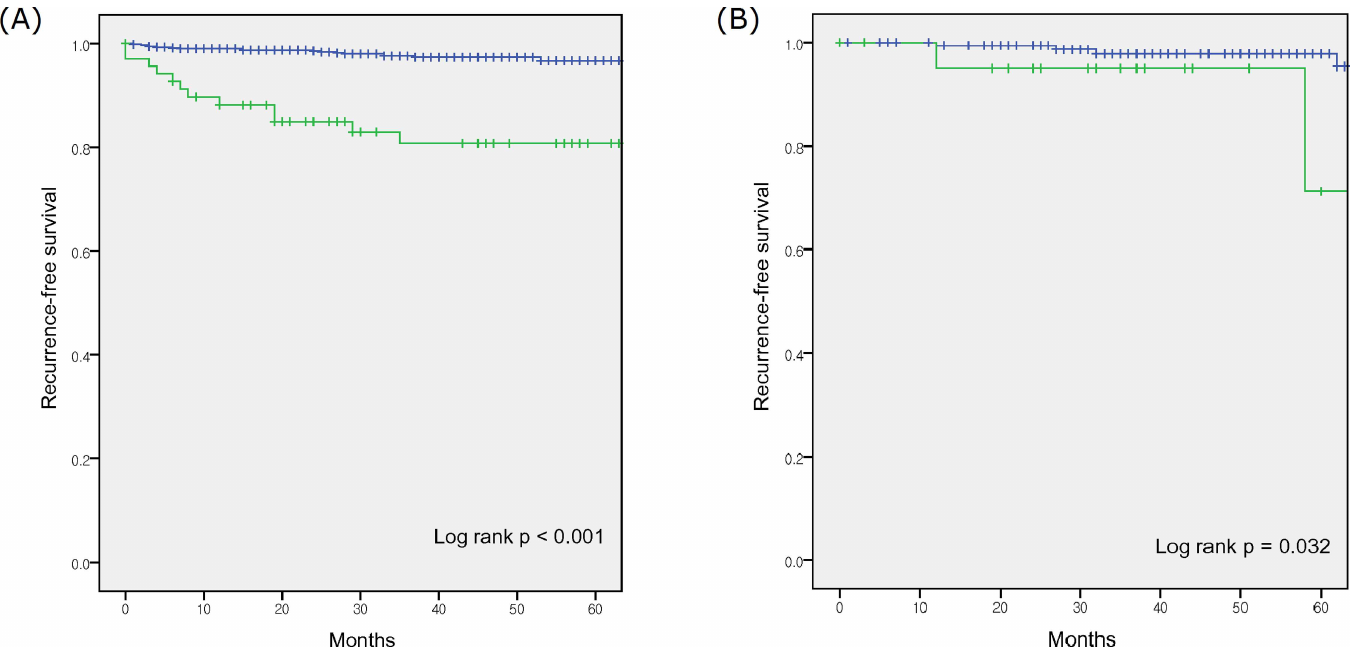
Fig 2. Kaplan-Meier survival curves for recurrence-free survivals. (A) the pT1 (blue curve) and pT3a upstaginggroups (green curve) of the clear cell subtype, and (B) the pT1 (blue curve) and pT3a upstaginggroups (green curve) of the non clear cell subtypes.